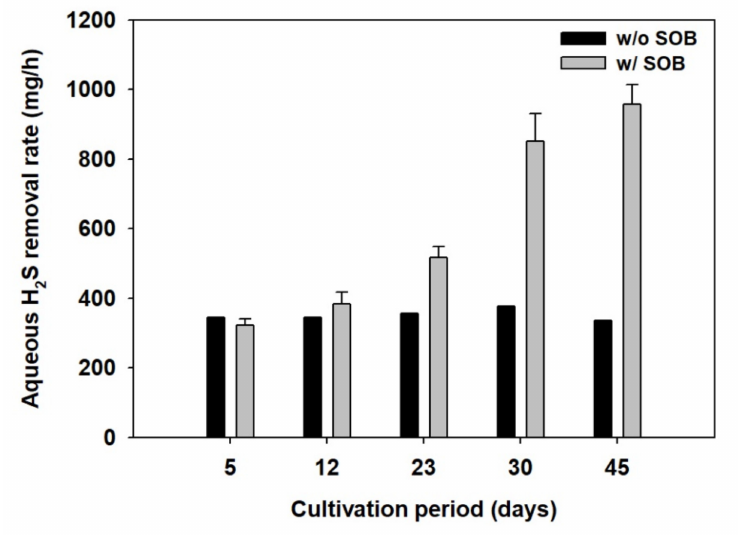
Figure 3. Variation of H 2 S removal rate depending on the cultivation periods. The error bars indicate the standard deviation of triplicate